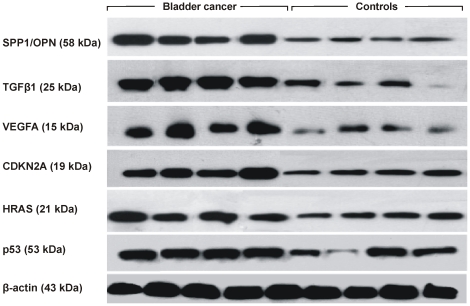
Representative bands depicting the expression of SPP1/OPN (58 kDa), TGFβ1 (25 kDa), VEGFA (15 kDa), CDKN2A (19 kDa), HRAS (21 kDa) and p53 (53 kDa) proteins in 4 BC and 4 control samples, using Western blotting.β-actin (43 kDa) was used as loading control.